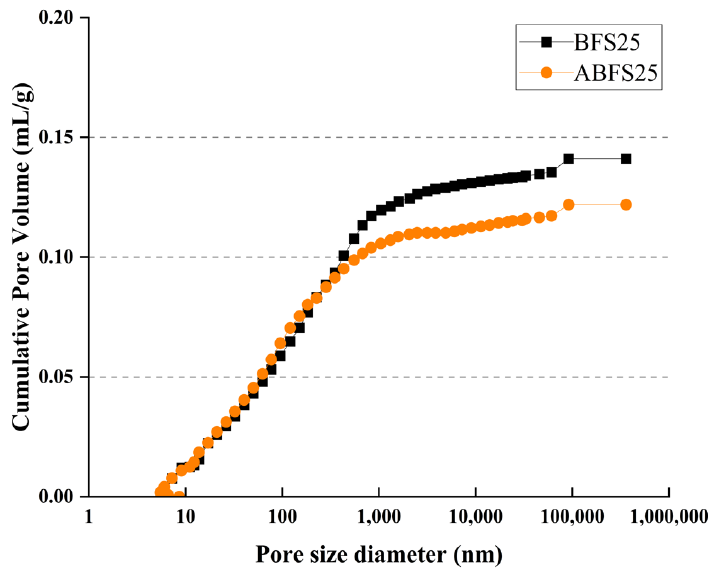
Figure 17. Porosity results for BFS25 and ABFS25.